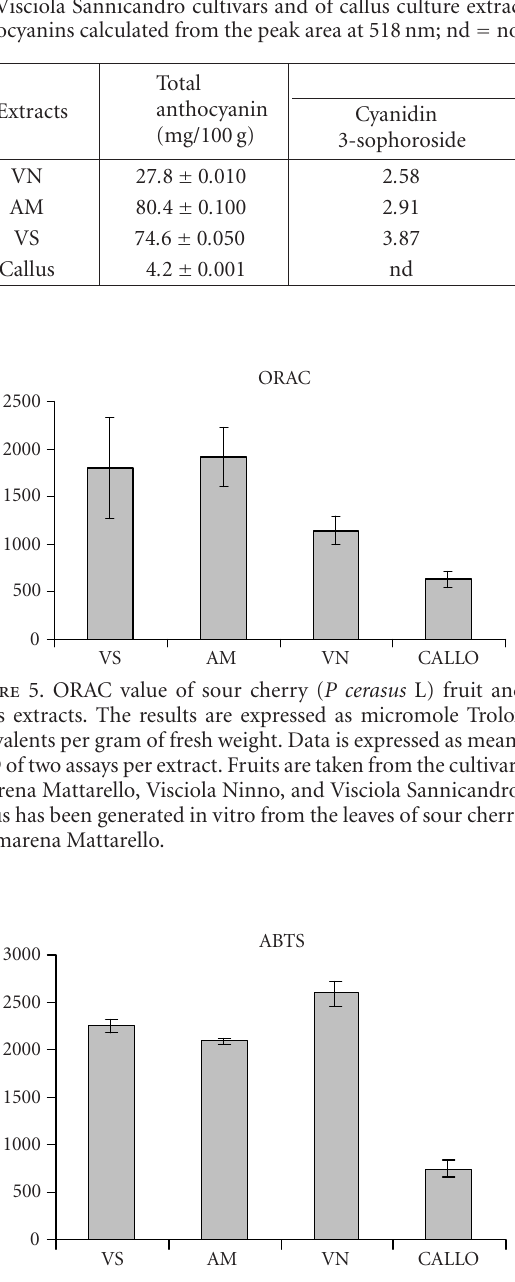
Figure 6. TEAC value of sour cherry ( P cerasus L) fruit and callus extracts. The results are expressed as micromole Trolox equivalents per gram of fresh weight. Data is expressed as means ± SD of two assays per extract. Fruits are taken from the cultivars Amarena Mattarello, Visciola Ninno, and Visciola Sannicandro. Callus has been generated in vitro from the leaves of sour cherry cv Amarena